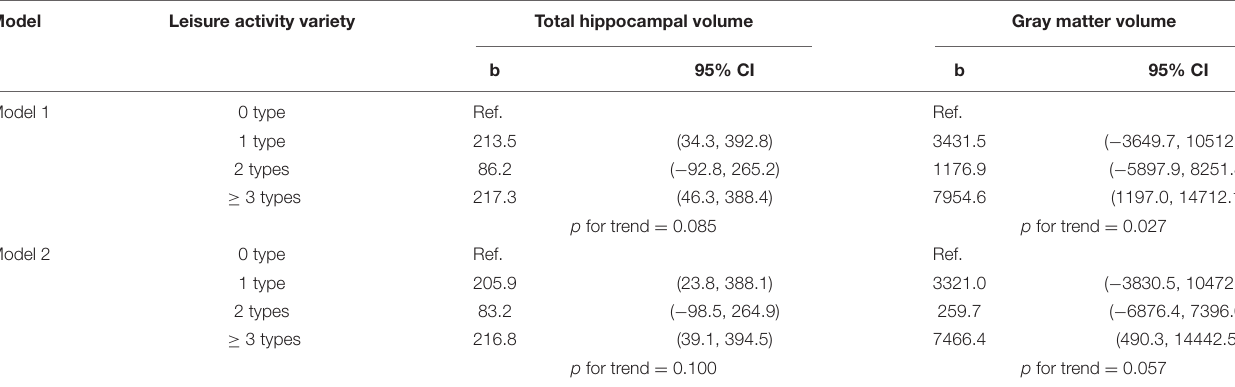
TABLE 3 | Association between leisure activity variety and brain volume: Results of multiple regression analysis.